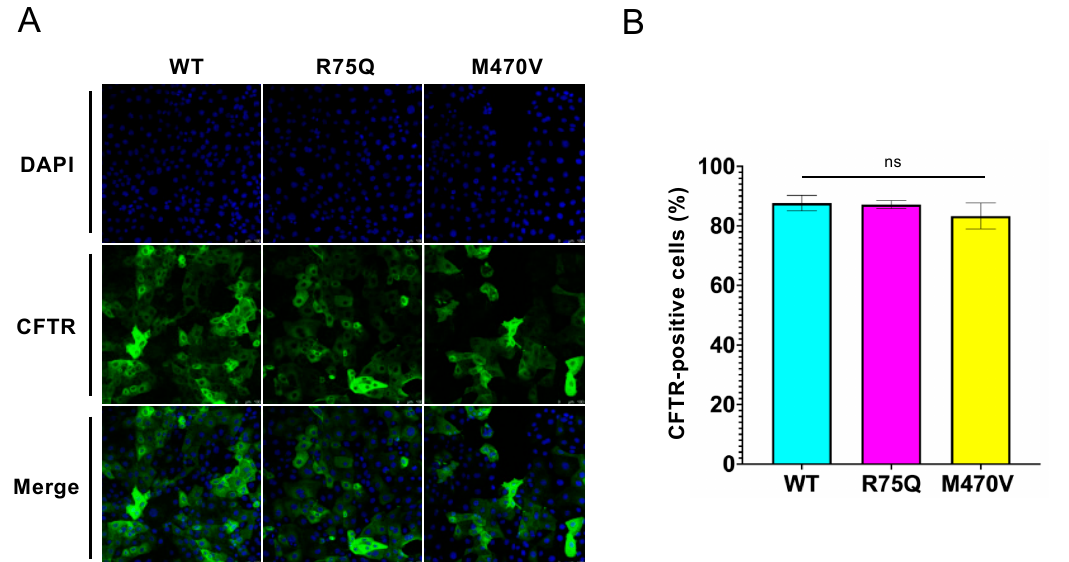
Figure 2. The transduction efficiency of the exogenous CFTR variants in the CFBE Tet-on cells. ( A ) Fluorescence micrographs of CFBE Tet-on cells expressing WT, R75Q, or M470V-CFTR immunos- tained using an anti-HA antibody with Alexa 488 conjugated secondary antibody in permeabilized cells. DAPI was used for nuclear staining. ( B ) The transduction efficiency was calculated as the percentage of the CFTR-expressing cells in 4–5 randomly selected areas containing >130 cells. The number of the cells used for the analysis is as follows; WT-CFTR 1402 cells, R75Q-CFTR 1280 cells, and M470V-CFTR 796 cells. Statistical significance was assessed by one-way ANOVA (ns, not significant). Data represent mean ± SE.